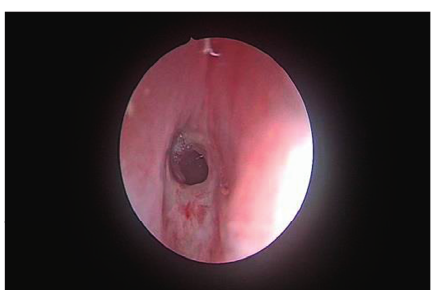
Figure 5: Grade II subglottic stenosis.